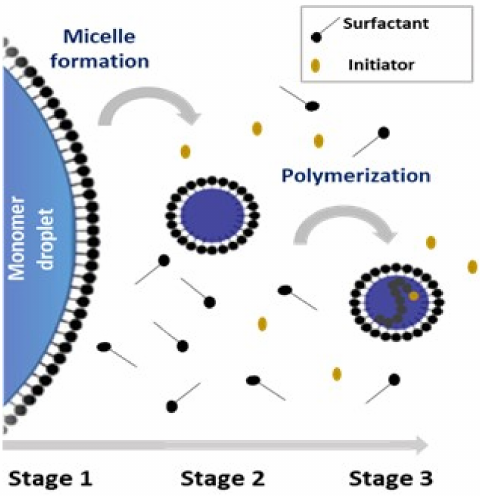
Figure 5. Schematic representation of different stages of emulsion